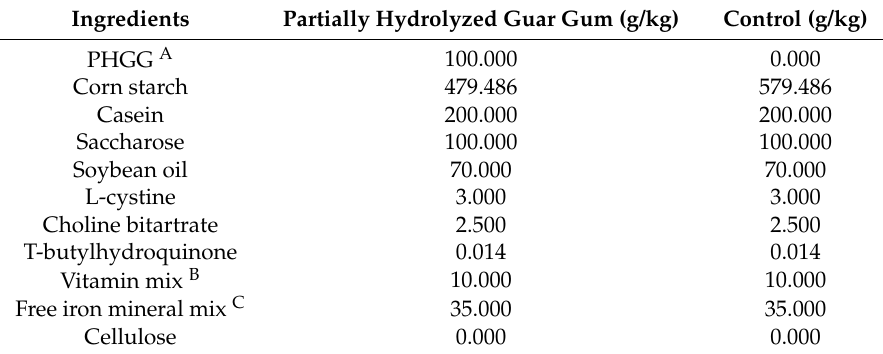
Table 1. Composition of the American Institute of Nutrition Rodent Diets for growth, pregnancy and lactation (AIN93-G) diet indicated for growing rats, modified by replacing 50 g of cellulose and 50 g of starch for 100 g of partially hydrolyzed guar gum (PHGG) or corn starch (control diet) and a free iron mineral mix. Ingredients Partially Hydrolyzed Guar Gum (g/kg) Control (g/kg) PHGG A